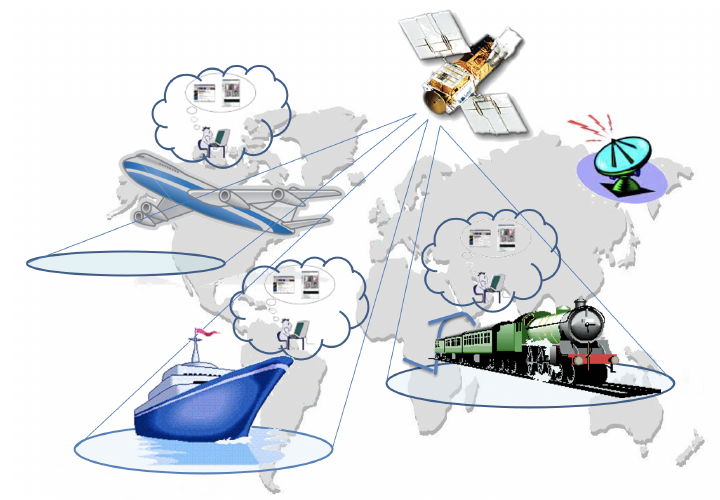
Figure 1. Mobile satellite